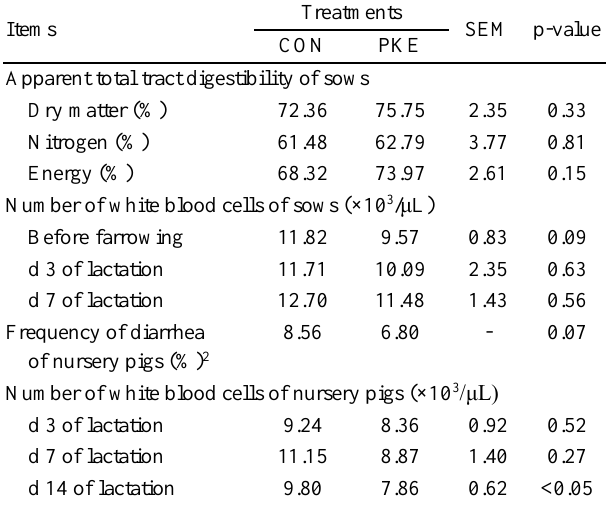
Table 3. Effects of palm kernel expellers on apparent total tract digestibility, number of white blood cells, and frequency of diarrhea